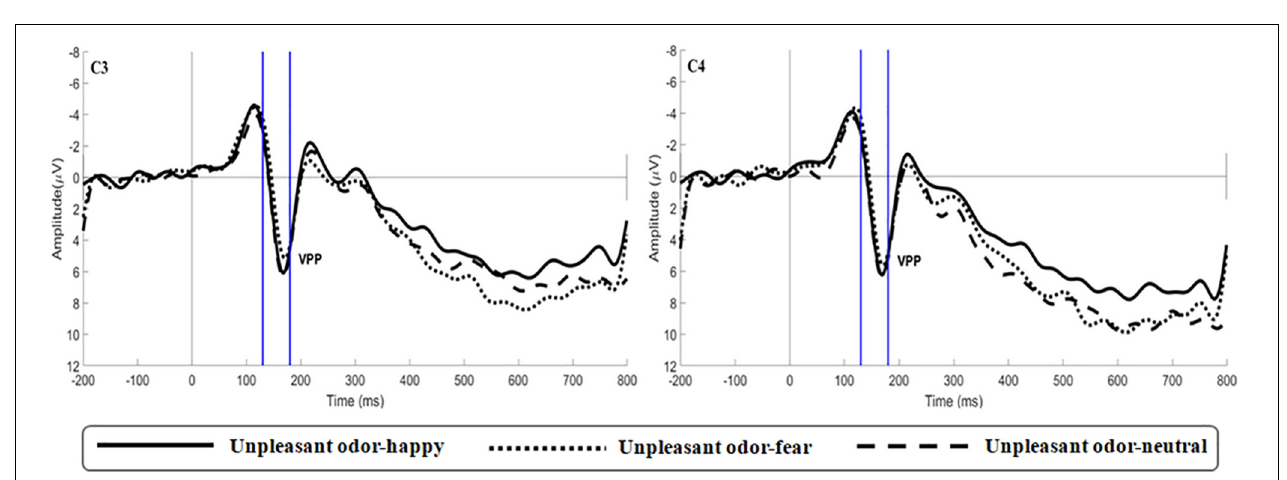
FIGURE 7 | Average ERP waveforms of VPP for happy, fear and neutral in the unpleasant odor contexts recorded at electrodes C3 and C4.